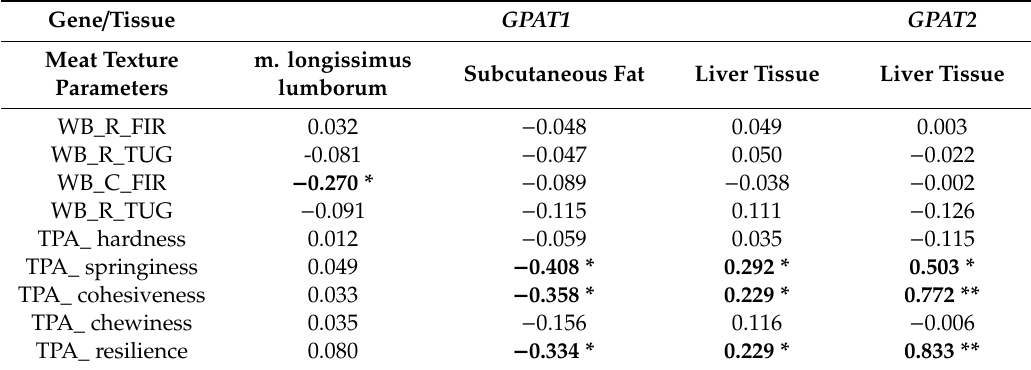
Table 3. Correlation between the expression level of the GPAT1 gene in m. longissimus lumborum, subcutaneous fat, liver tissue and the expression level of GPAT2 gene in liver tissue with meat texture parameters (* p ≤ 0.05; ** p ≤ 0.01).